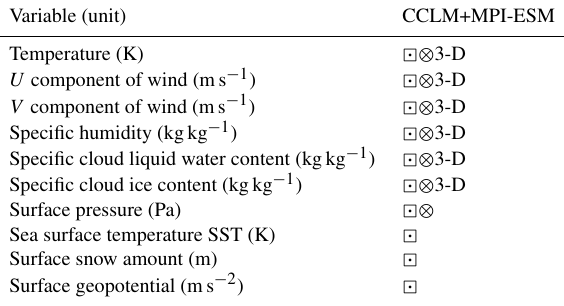
Table 4. Variables exchanged between CCLM and the MPI-ESM global model. The CF standard-names convention is used. Units are given as defined in CCLM. ⊗ : information is sent by CCLM; : information is received by CCLM. 3-D indicates that a three- (cid:26) dimensional field is sent/received. Variable (unit)